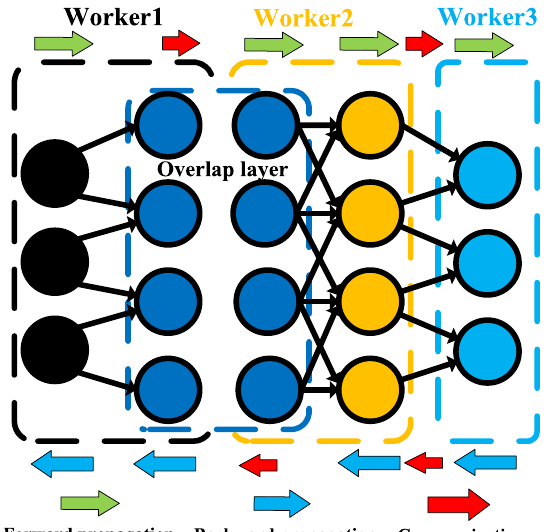
Fig. 7 An example for three workers with